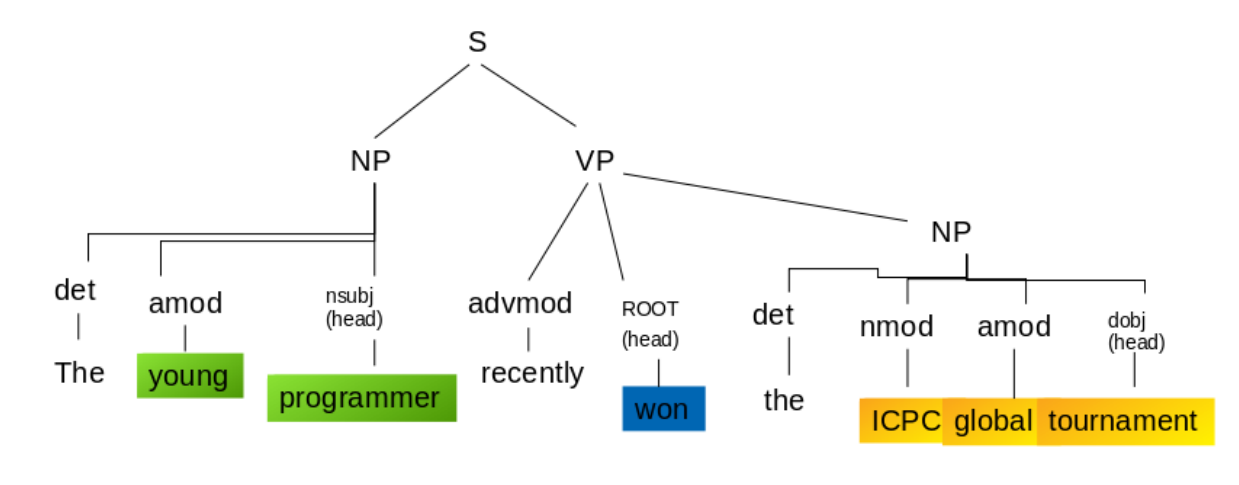
Figure 5. Tree parser representation of the sentence: “The young programmer recently won the ICPC global tournament”.